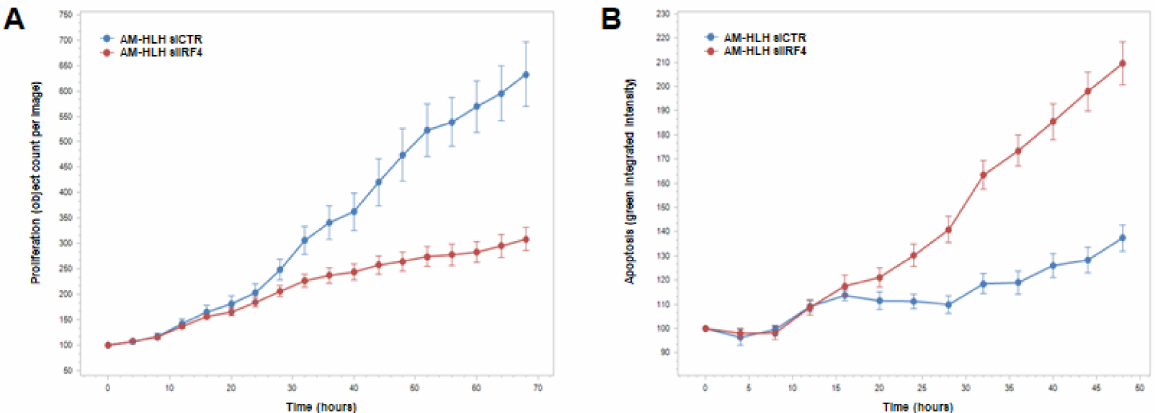
Figure 5. IRF4 impacts proliferation and apoptosis in AM-HLH. ( A ) SiRNA-mediated knockdown of IRF4 resulted in reduced proliferation while ( B ) apoptosis was enhanced. The data were generated by live-cell-imaging. Standard deviations are indicated in the figure, the p -values for the last points of time are p = 0.000338 and p = 0.00208, respectively.